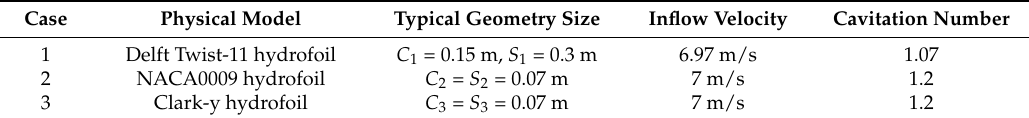
Table 1. Summary of the simulation